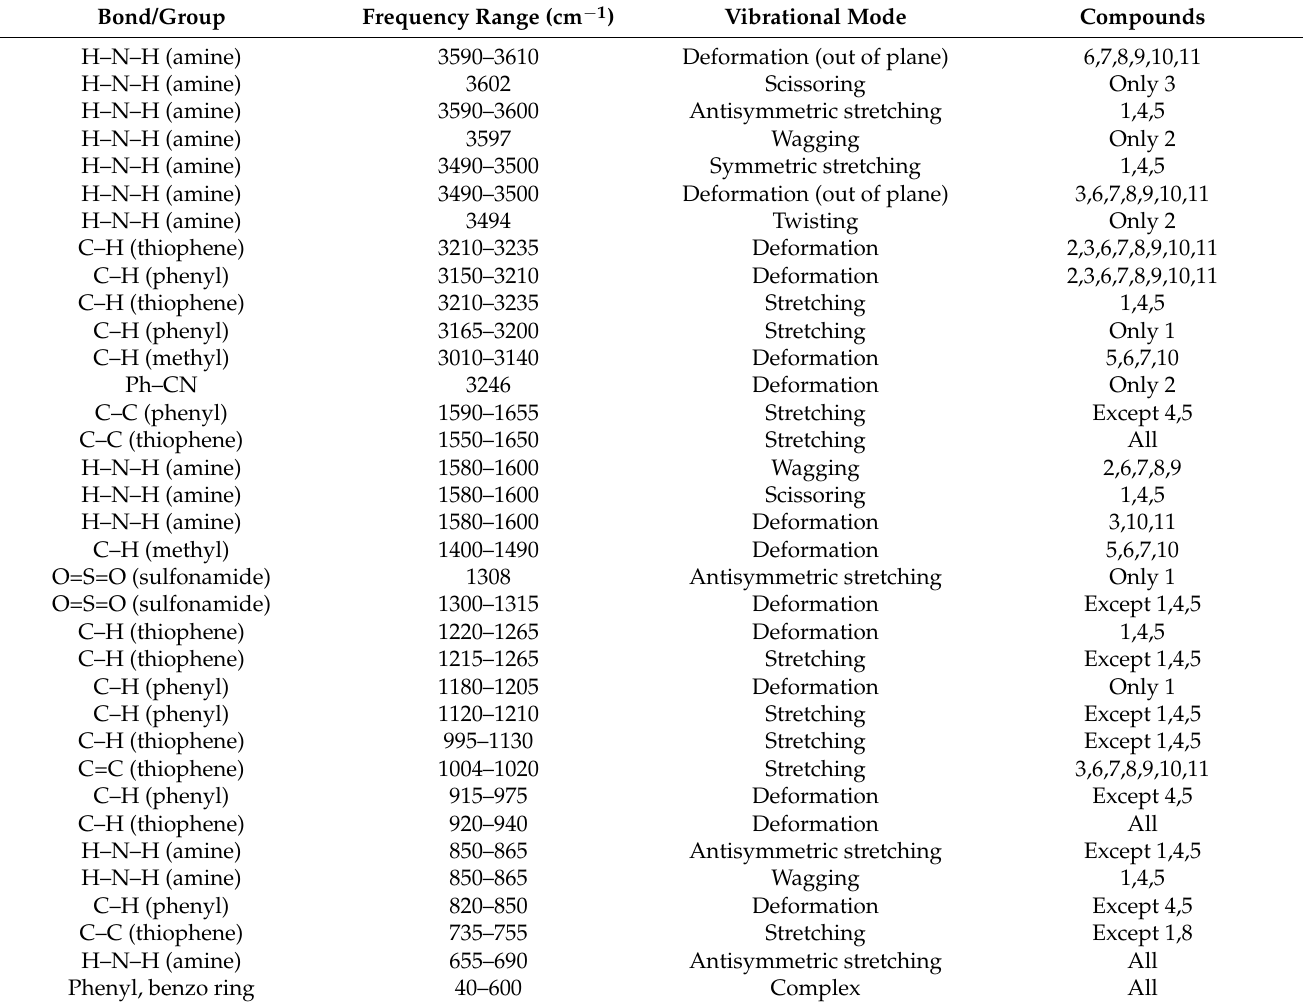
Table 5. Calculated frequency ranges and vibrational modes based on them for compounds 1 – 11